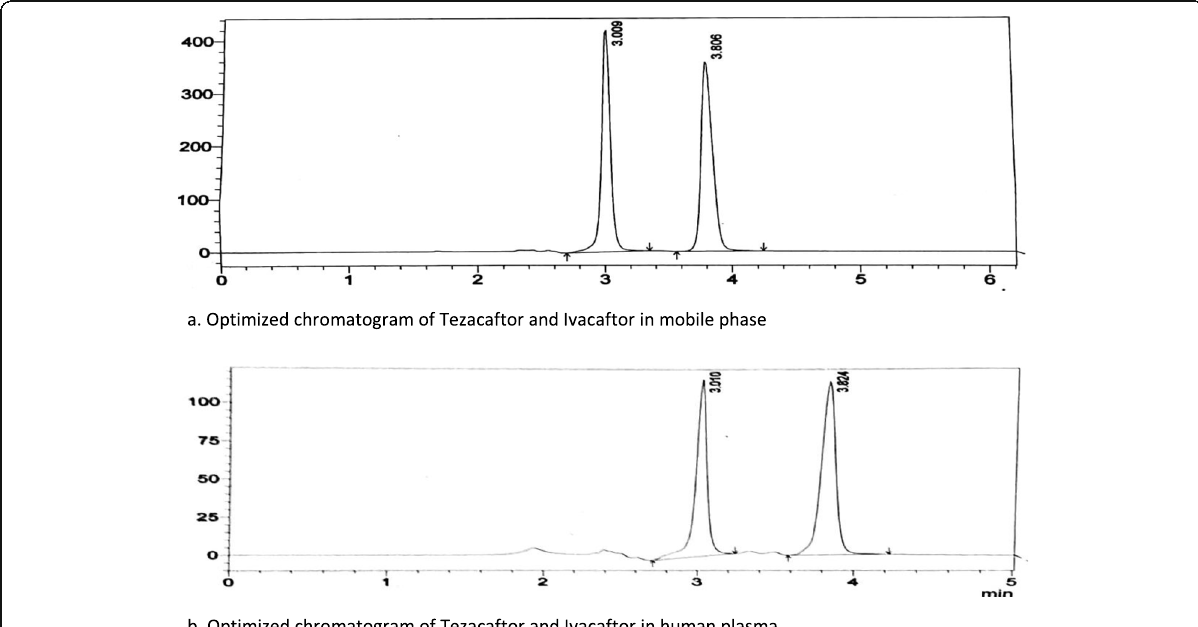
Fig. 5 Optimised chromatograms of IVA and TEZ. a Optimized chromatogram. b Optimized chromatogram in mobile phase in human